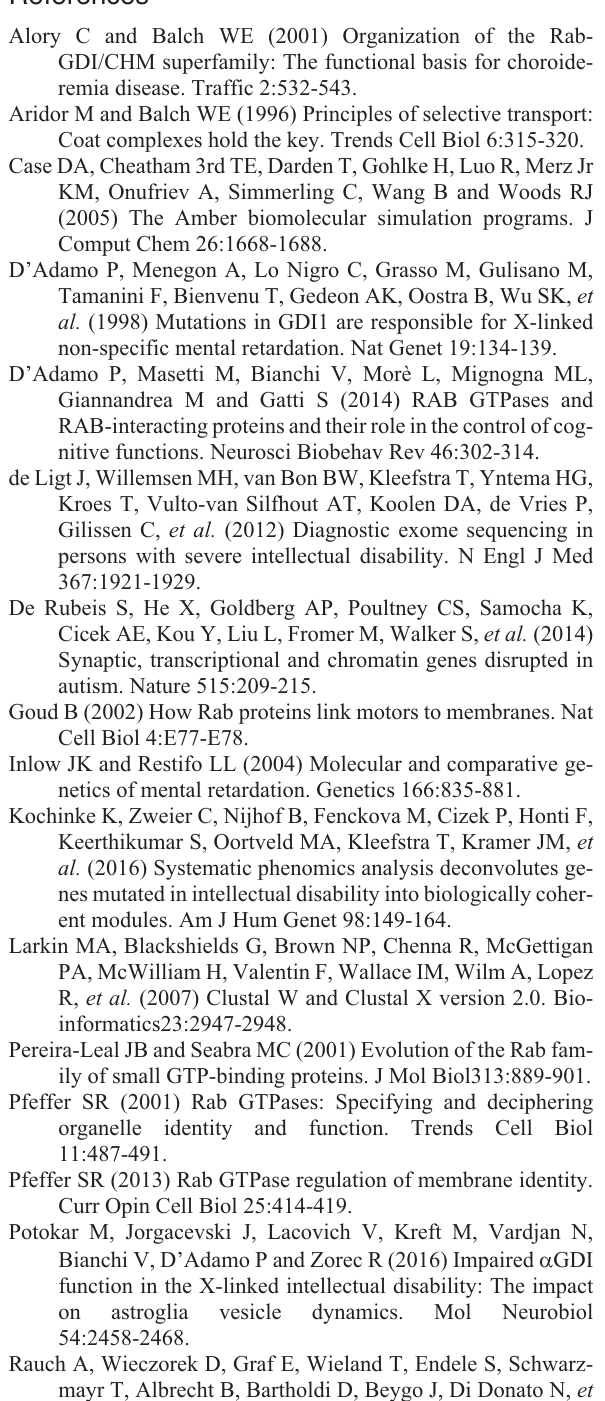
Table S1 - Characteristics of primers for amplification of candidate pathogenic regions on the genomic DNA Table S2 - Possible consequence of GDI1 p.Gly237Val mutation predicted by various